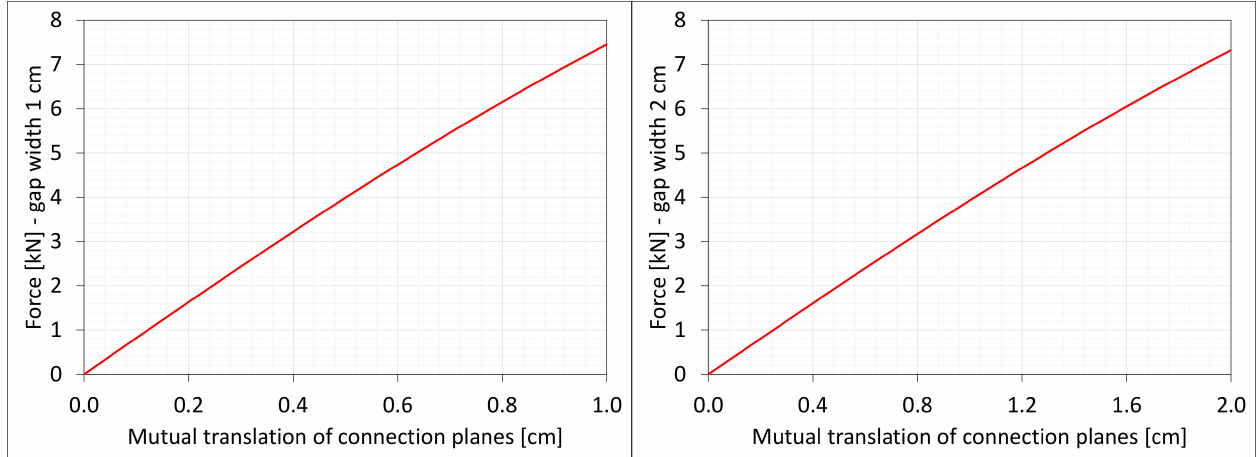
Figure 14. Equilibrium paths for shear force V y . The width of the gap is equal to 1.0 cm, left graphic, and 2.0 cm, right graphic.